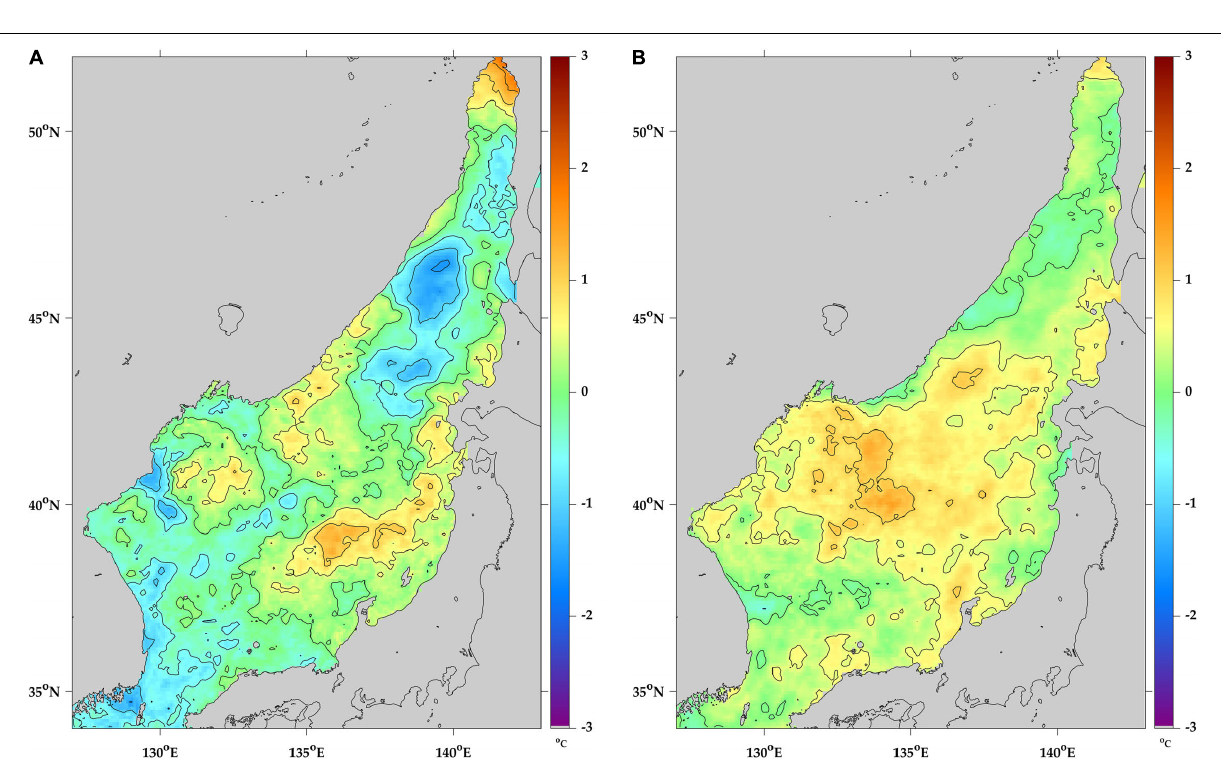
Frontiers in Marine Science |